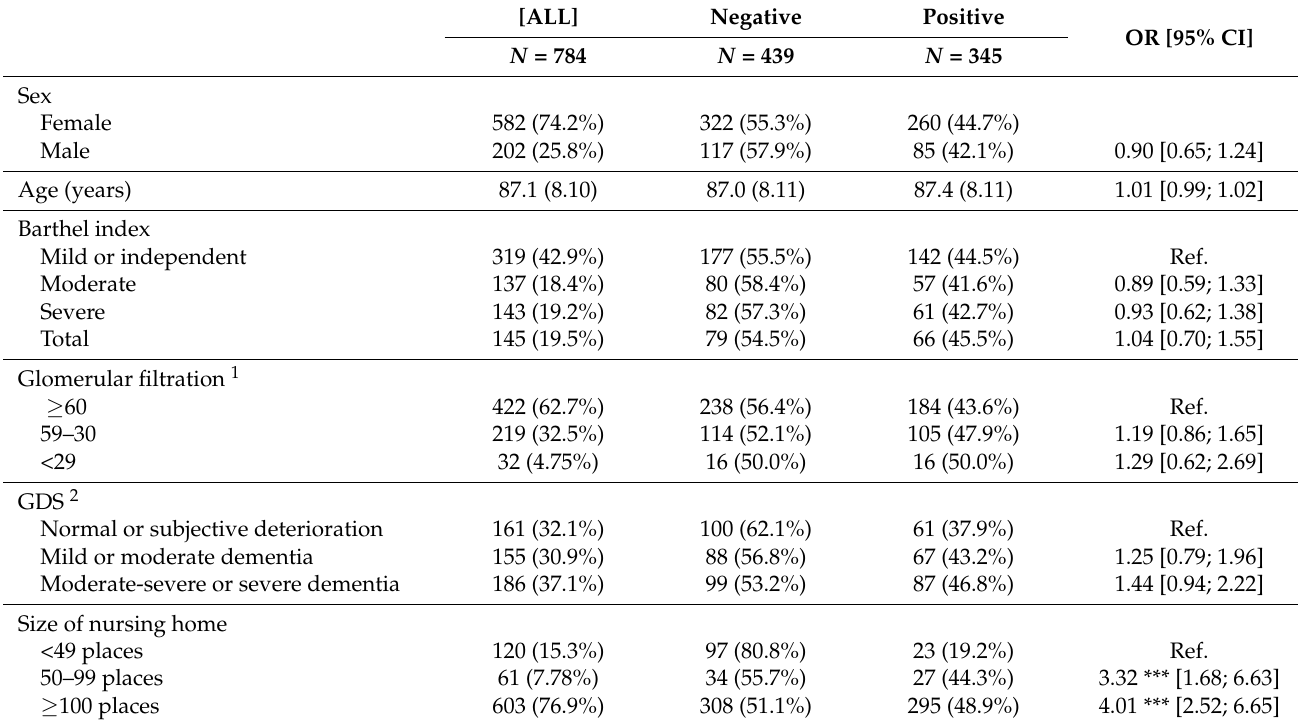
Table 2. Factors related to SARS-CoV-2